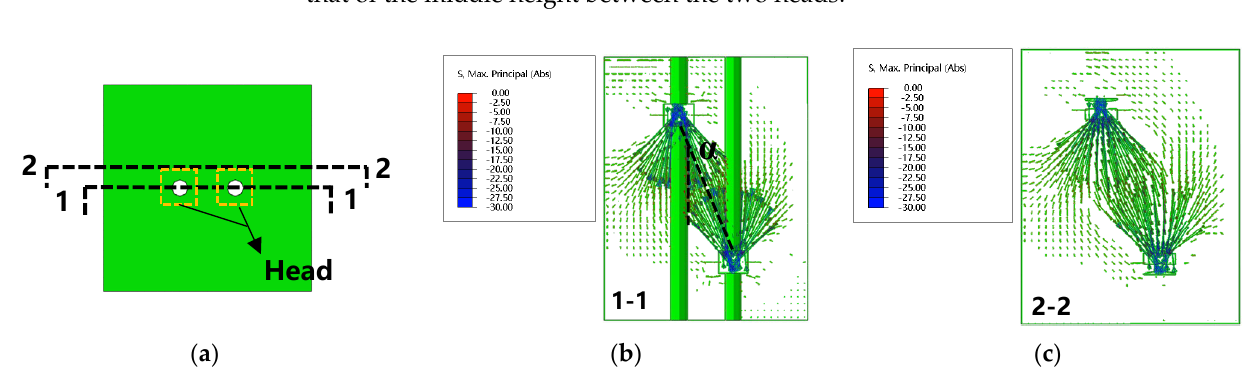
Figure 34. Angle a against the direction of diagonal crack of specimen M4-D12-7.5d. Through the stress vector contours in Figure 35, the diagonal strut can be recognized of the bottle shape, which is the same as the strut in STM model. Again, the direction of the compressive stress vectors matches the angle a . For the diagonal strut, the compres- sion-bearing area near the head is smaller but with a higher compression stress compared to that of the middle height between the two heads.